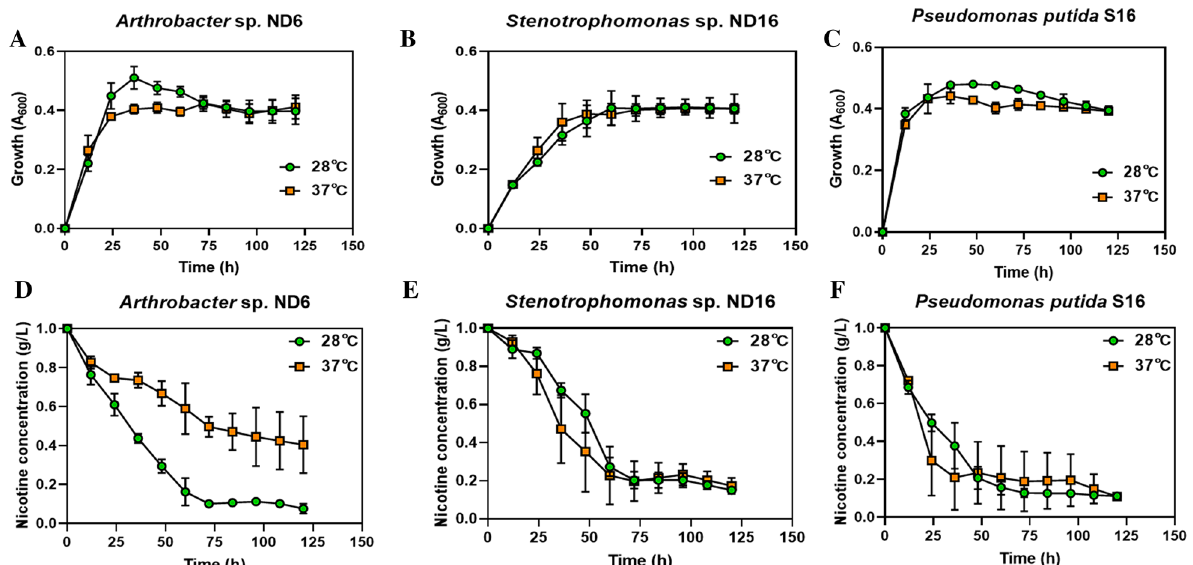
Fig. 4 Effects of temperature on bacterial growth and nicotine degradation. Nicotine-degrading bacteria Arthrobacter nitrophenolicus ND6 ( A , D ), Stenotrophomonas geniculata ND16 (B, E), and control strain Pseudomonas putida S16 (C, F). A – C Growth curves of strains under different temperatures; D – F nicotine-degrading curves of strains under different